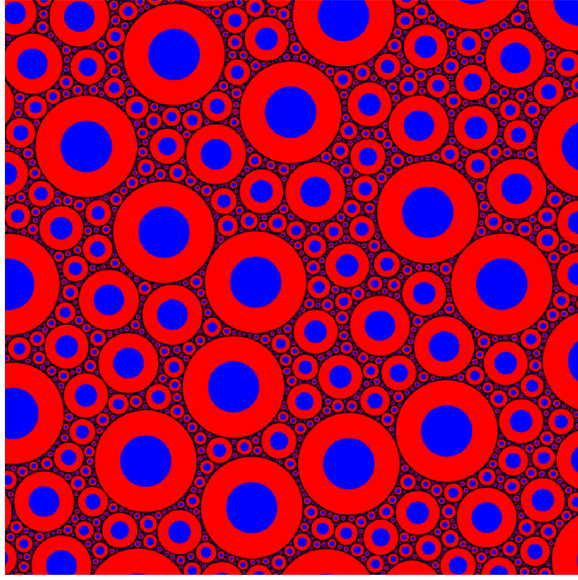
FIG. 3. Schematic of the optimal multiscale coated-spheres model that realizes the isotropic Hashin-Shtrikman bounds on ε e [85]. Each composite sphere is composed of a spherical inclusion of one phase (dispersed phase) that is surrounded by a concentric spherical shell of the other phase such that the fraction of space occupied by the dispersed phase is equal to its overall phase volume fraction. The composite spheres fill all space, implying that their sizes range down to the infinitesimally small. When phase 2 is the disconnected inclusion (dispersed) phase, this two-phase medium minimizes and maximizes the effective static dielectric constant ε for prescribed volume fraction e and contrast ratio, when ε 2 = ε 1 > 1 and ε 2 = ε 1 < 1 , respectively. It has recently been proved that these highly degenerate optimal Hashin-Shtrikman multiscale distributions of spheres are hyperuniform